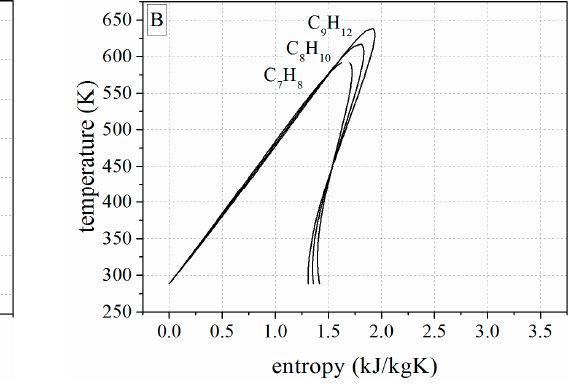
Figure A1. T,s -diagrams of investigated working fluids ( A ) n -alkanes; ( B ) alkylbenzenes; ( C ) linear siloxanes; and ( D ) cyclic siloxanes. References